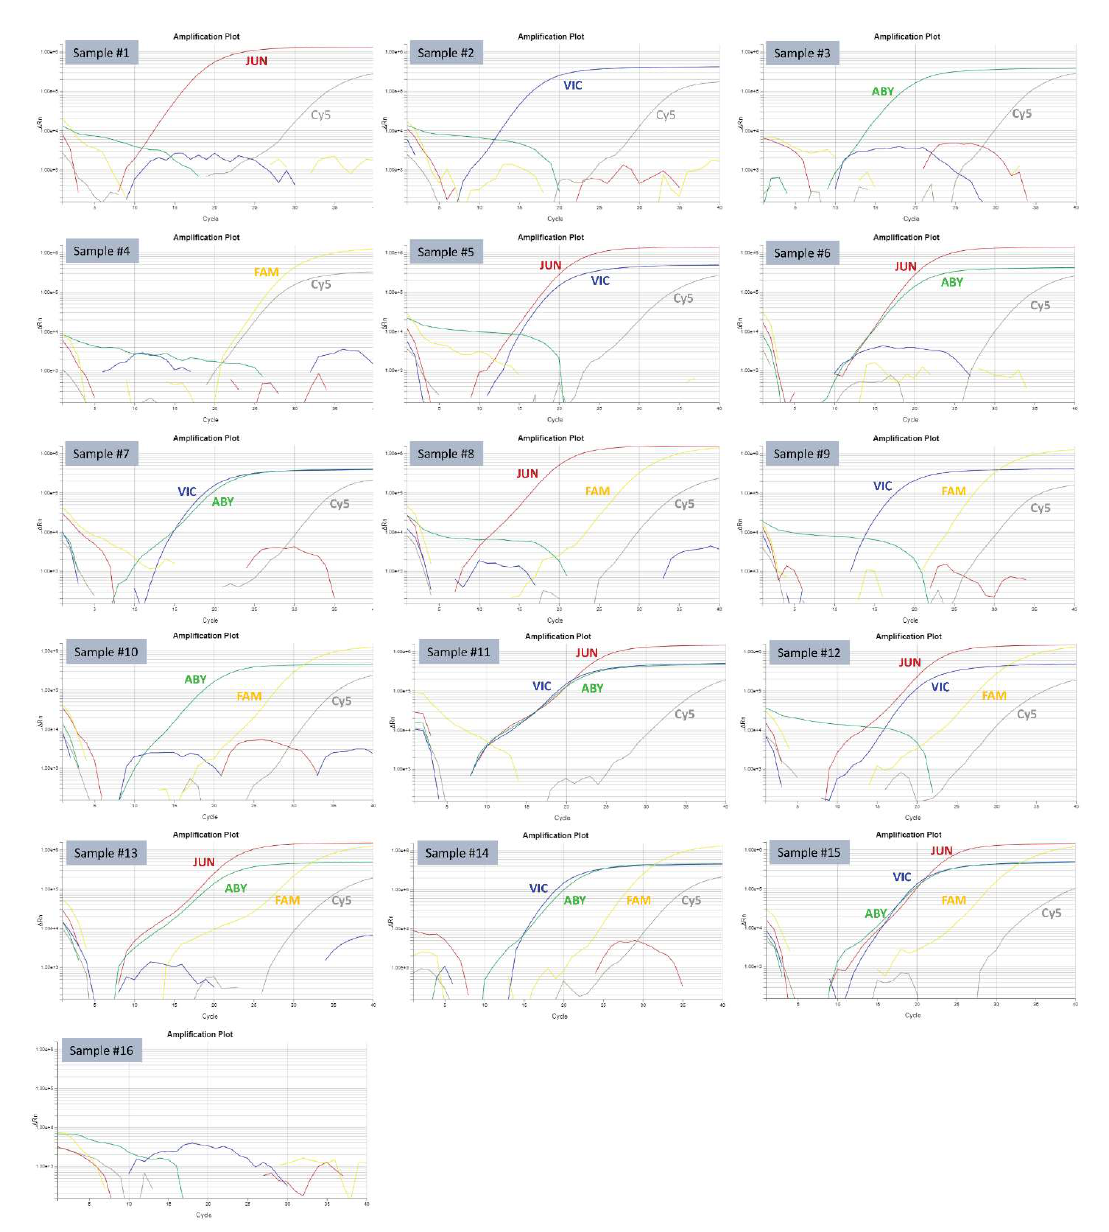
Figure 1. Amplification plots of 16 samples tested by the PEDV/PDCoV/TGEV/SADS-CoV/XIPC 5-plex PCR. The amplification curves corresponding to each fluorescence dye (JUN, VIC, ABY, FAM, and Cy5) are labeled accordingly. The identities of the samples #1–#16 are denoted in Table 4. The analytical sensitivity of the 5-plex PCR was first evaluated by testing RNA ex- tracts from 10-fold serial dilutions of PEDV, TGEV, and PDCoV cell culture isolates in